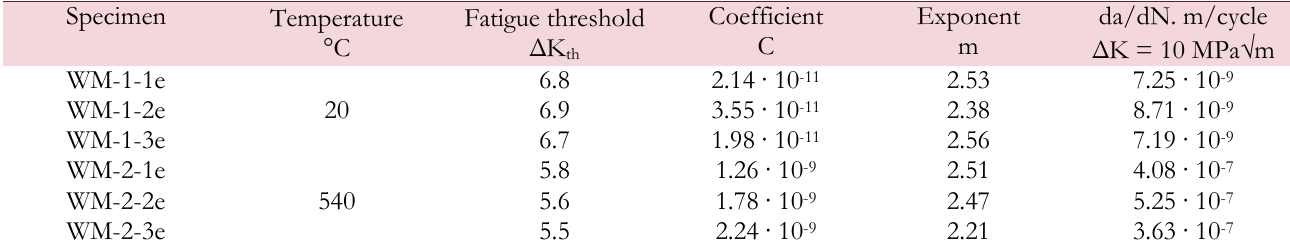
Table 7: Fatigue crack growth parameters for specimens with notches in WM.